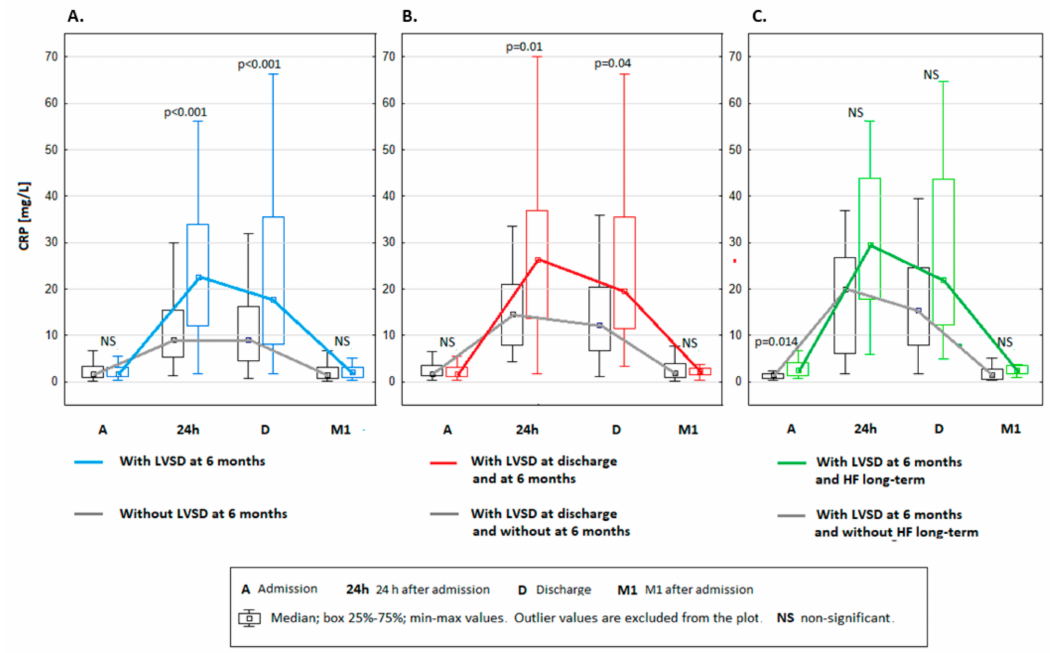
Figure 2. Comparison of C-reactive protein (CRP) median concentration during hospitalization for ST-segment elevation myocardial infarction and at 1 month after discharge between di ff erent groups of patients: ( A ) with ( n = 35 patients) and without ( n = 164) left ventricular systolic dysfunction (LVSD) 6 months after discharge; ( B ) with LVSD at discharge ( n = 57) and who either exhibited LVSD 6 months after discharge ( n = 29) or did not exhibit LVSD after 6 months ( n = 28); ( C ) with LVSD 6 months after discharge ( n = 35) who either had hospitalization for heart failure (HF) ( n = 16) or did not have hospitalization for HF ( n = 19) in long-term